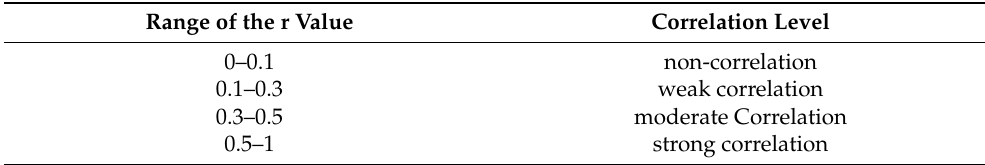
Table 7. Correlation coefficient evaluation